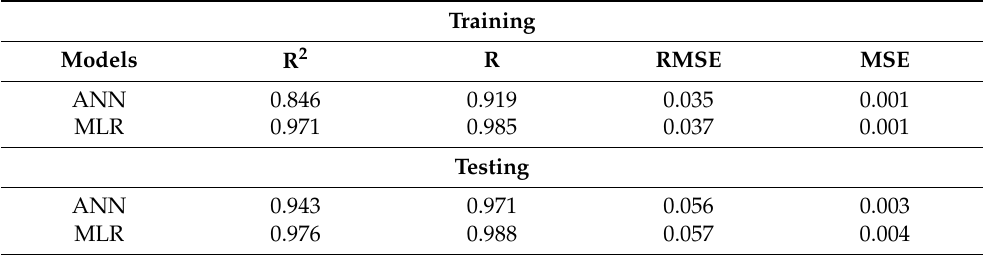
Table 1. Results of the